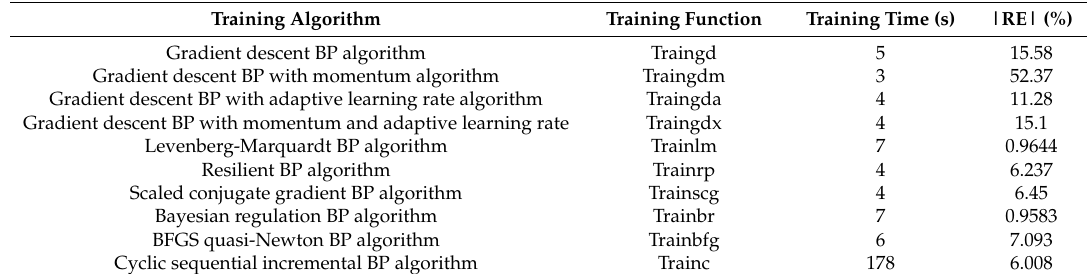
Table 1. Performance of BP neural network using different training algorithms.